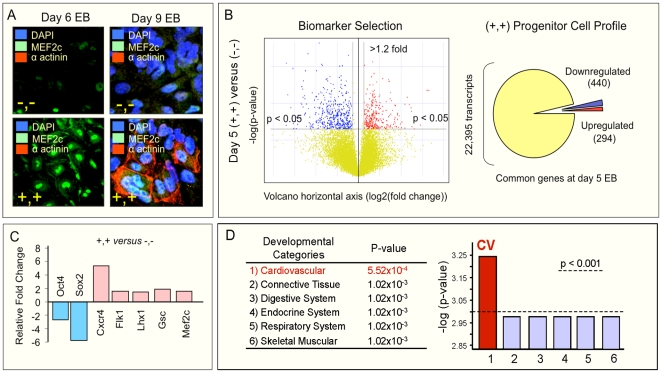
CXCR4/Flk-1 biomarker signature enriches for cardiac progenitors.(A) Sorted double positive (+,+) and double negative (−,−) cells were tracked for phenotypic differentiation in culture. Double positive cells displayed Mef2C nuclear localization at day 6 and expressed sarcomeric α-actinin at day 9 (lower panels). Double negative cells did not express markers of cardiac differentiation (upper panels). (B) Volcano plot analysis of gene expression data from double positive cardiac progenitors revealed significant differences compared to day 5 double negative cohorts. Red dots, differentially up-regulated transcripts (≥20% fold change, p<0.05); blue dots, down-regulated transcripts (≥20% fold change, p<0.05); yellow dots, shared transcriptome at day 5 embryoid bodies, independent of CXCR4/Flk-1 biomarker expression. (C) RT-PCR confirmed microarray predicted gene expression trends for selected transcripts. Blue, down-regulated, Red, up-regulated. (D) Ingenuity functional analysis of the double positive progenitor transcriptome revealed an ontologic prioritization (1) of “Cardiovascular Development” (p = 5.52×10−4), compared to other physiological systems (2–6).